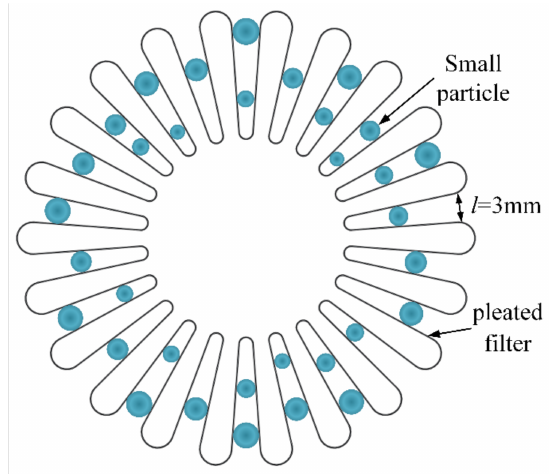
Figure 6. Schematic diagram of particle blockage in filter